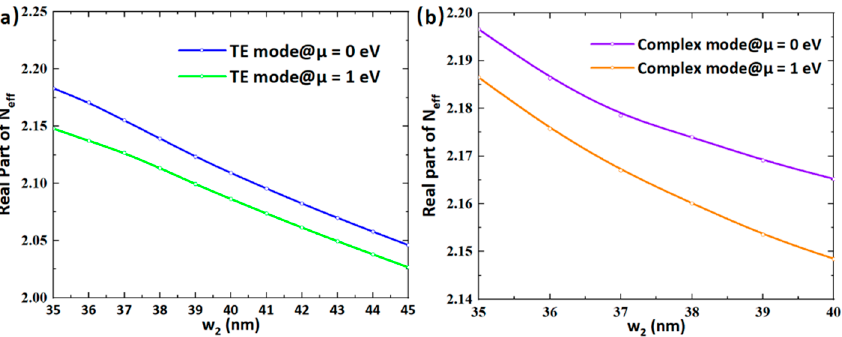
Figure 8. Re( N eff ) as a changing relationship of w 2 for ( a ) TE mode and ( b ) complex mode.